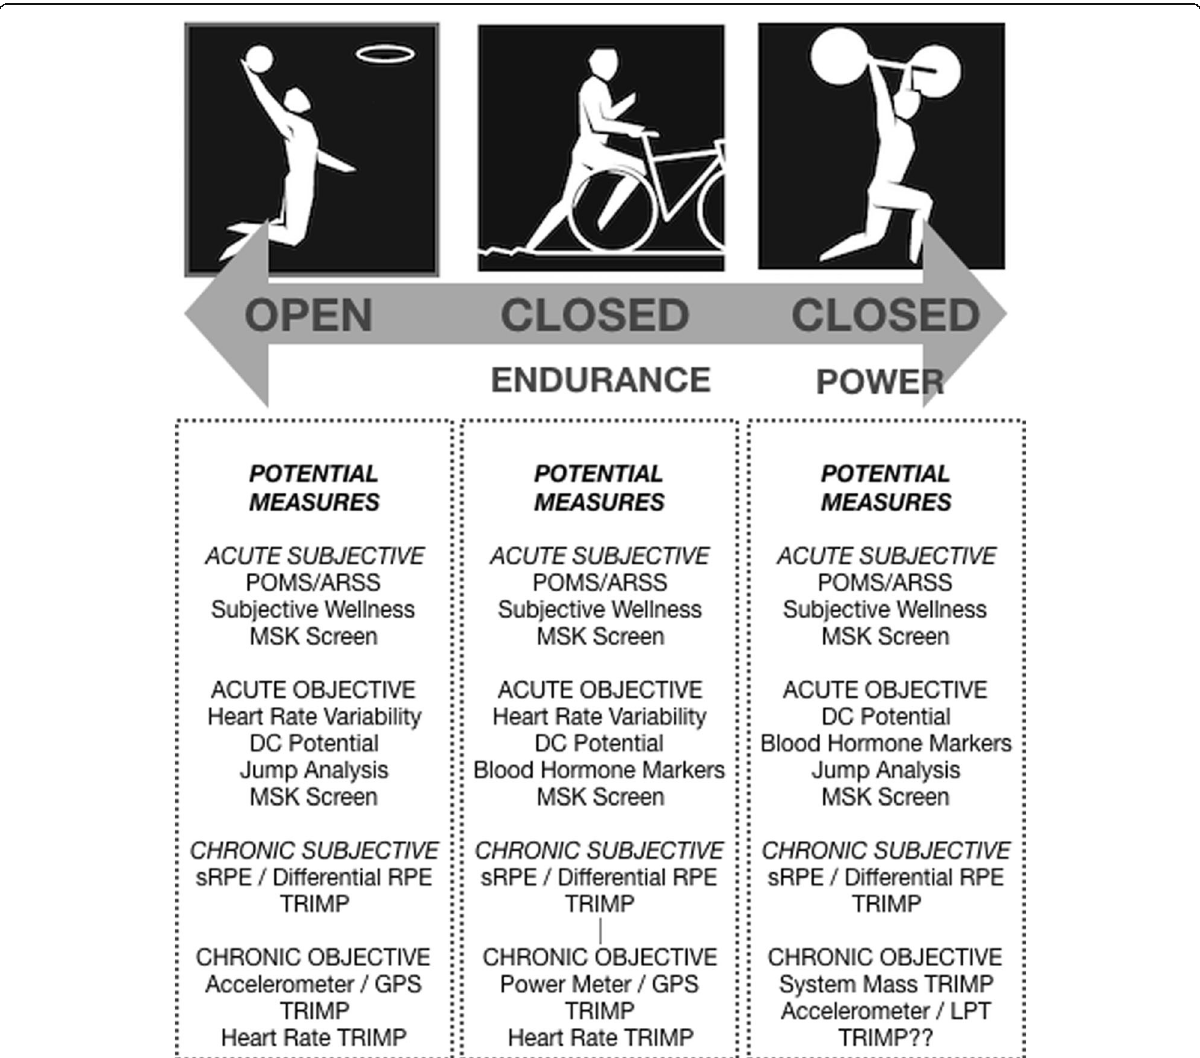
Fig. 3 A potential framework of “ acute ” and “ chronic ” decision-making tools for different types of sports. POMS, Profile of Mood States; ARSS, Acute Recovery and Stress Scale; MSK, musculoskeletal; DC, direct current; LPT, linear position transducer; GPS, Global Positioning System; RPE, rate of perceived exertion; TRIMP, training impulse. Individual London 2012 Olympic pictograms reproduced in complete figure with permission